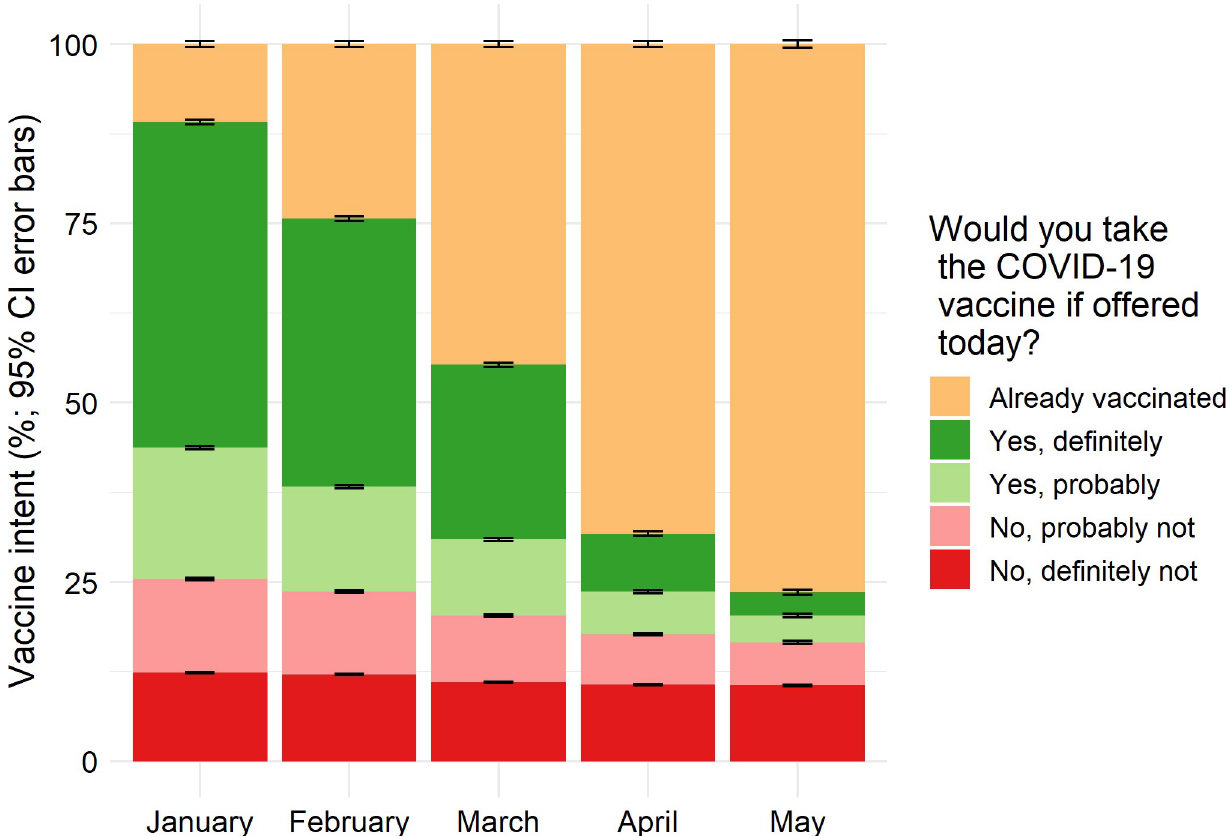
Fig 1. COVID-19 vaccine receipt and intent among US adults by month (January-May, 2021). Vaccine hesitancy decreased among adults each month from January to May, mostly due to a decrease in the response, “probably not” (-7.1 percentage points (%) [95% CI -7.2, -6.9]) versus “definitely not” (-1.8% [95% CI -1.9,